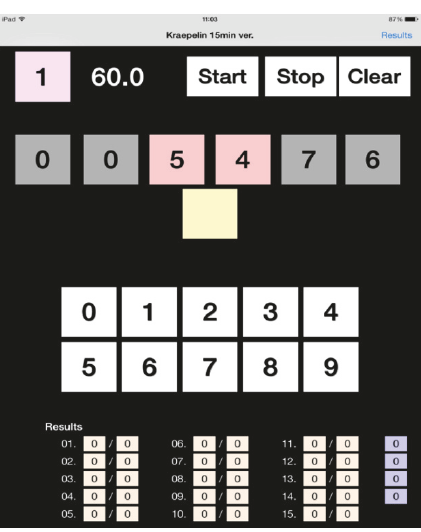
Figure 3: The calculation task application working on an iPad mini (cid:2) .